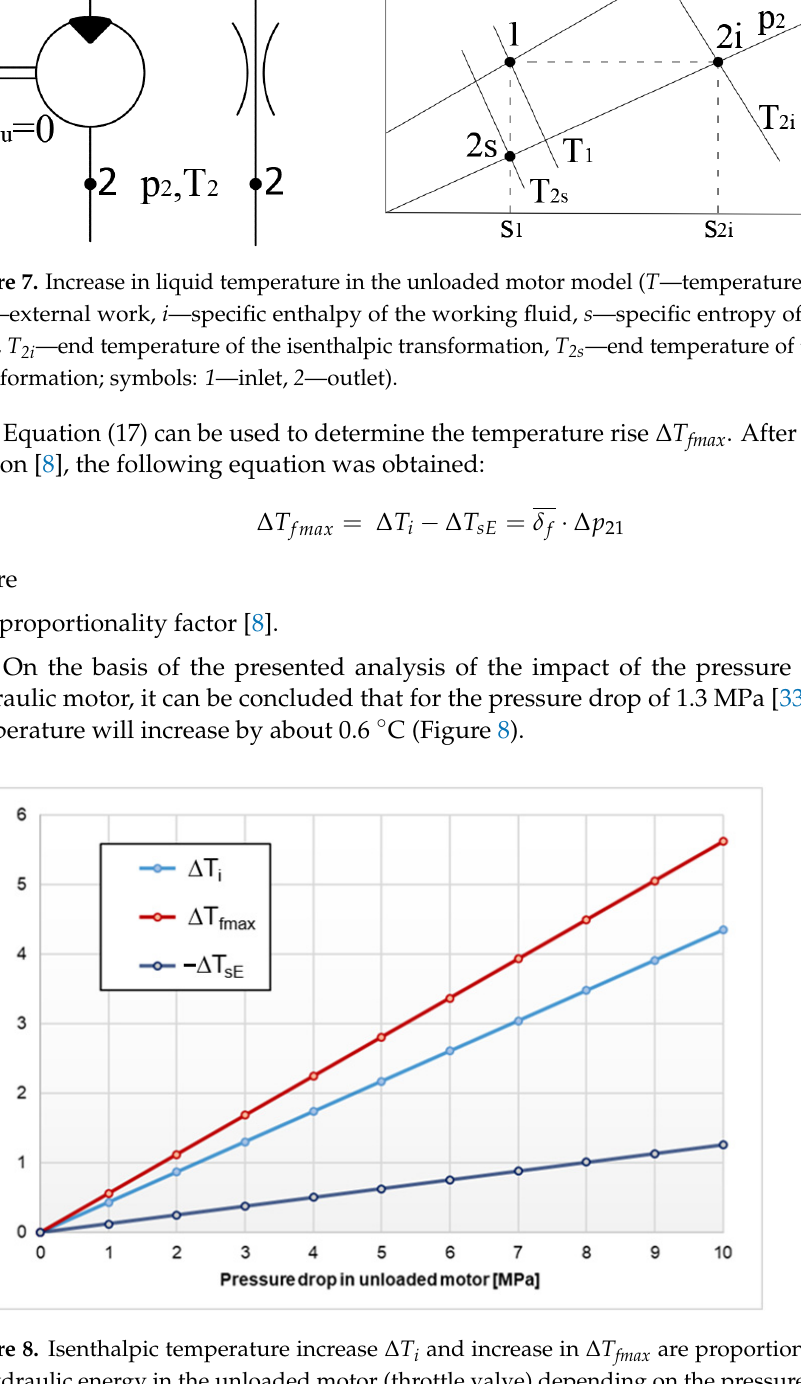
Figure 8. Isenthalpic temperature increase Δ T i and increase in Δ T fmax are proportional to the loss of hydraulic energy in the unloaded motor (throttle valve) depending on the pressure drop for the Hydrol 40 mineral oil at the temperature of 40 °C at the inlet.